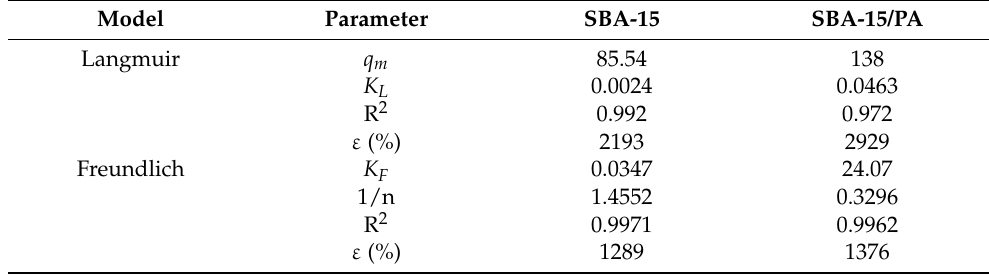
Figure 5. Isotherms for phenol adsorption from experimental data from aqueous solutions on silica and its modification. Table 4. Langmuir and Freundlich (two-parameter isotherms) parameters on silica and its